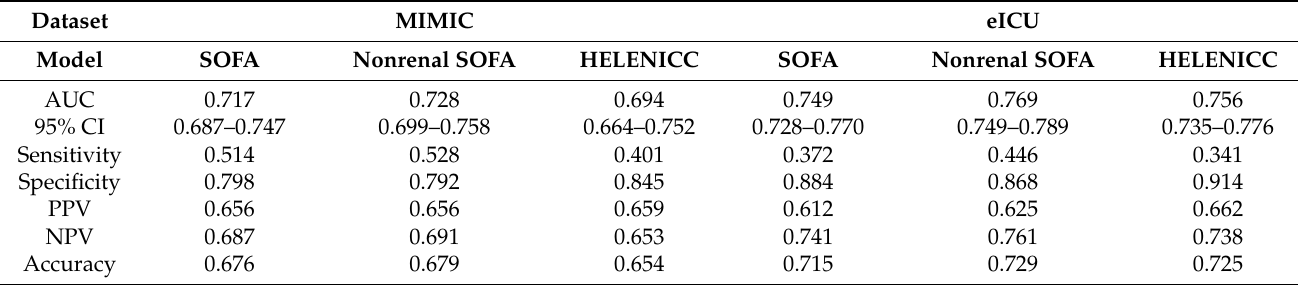
Table 2. Performance of the SOFA, nonrenal SOFA, and HELENICC scores 1 day before the beginning of dialysis in the MIMIC and eICU datasets.